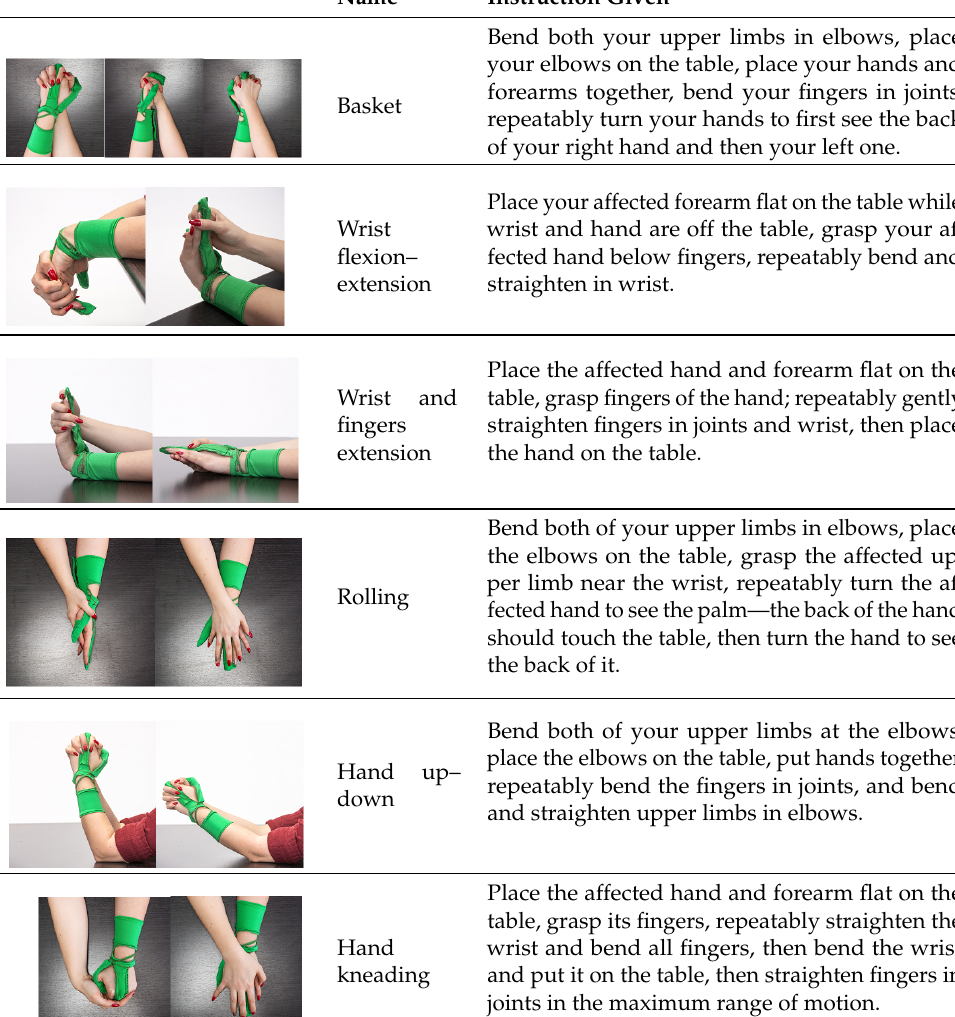
wrist and bend all fingers, then bend the wrist and put it on the table, then straighten fingers in joints in the maximum range of